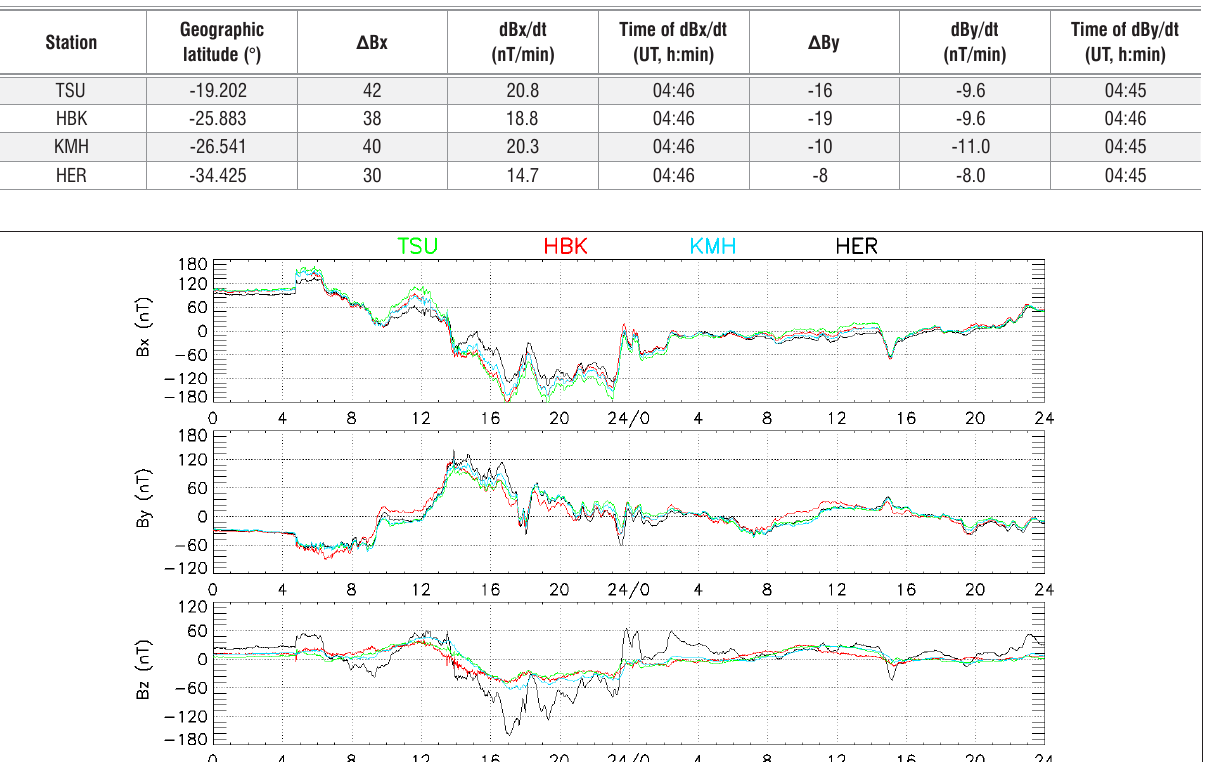
component occurred at all four stations during the x sudden storm commencement. The largest deviation from the mean over the four stations occurred in the B component measured at the z Hermanus station, which is closest to the coast. Figure 6b shows that the maximum rate of change in the B component occurred in the Hermanus y data and was not during the sudden storm commencement but during the main phase of the storm at about 14:00 and 18:00. The peak values in dB /dt (20.8 nT/min) were larger than the peak values in dB /dt x y (-11 nT/min), which seems to indicate a dominance of the ring current in causing the geomagnetic disturbance. On the other hand, the increase in the variation of the B component of the Hermanus observations relative z to the variation of the other observatories (Figure 5), and the increase in the maximum dB /dt from Tsumeb to Hermanus (Figure 6b) is consistent y with disturbances resulting from field-aligned currents. 13 (ΔB ) and decrease in B (ΔB ) and its highest rate of change in both components (dB /dt and dB /dt) x x y y x y